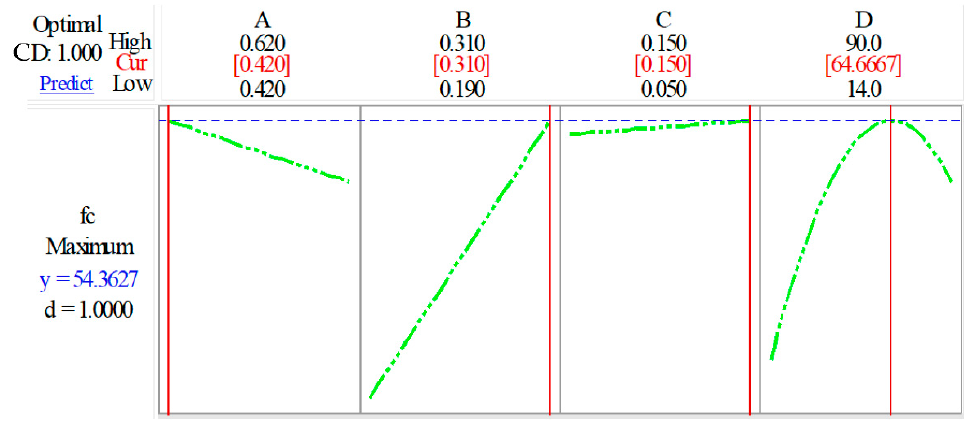
Figure 13. Optimisation plot for the response (fc, MPa). A is water/binder ratio, B is binder/aggregate ratio, C is CNA/(CNA+PLC), and D is curing age (d).